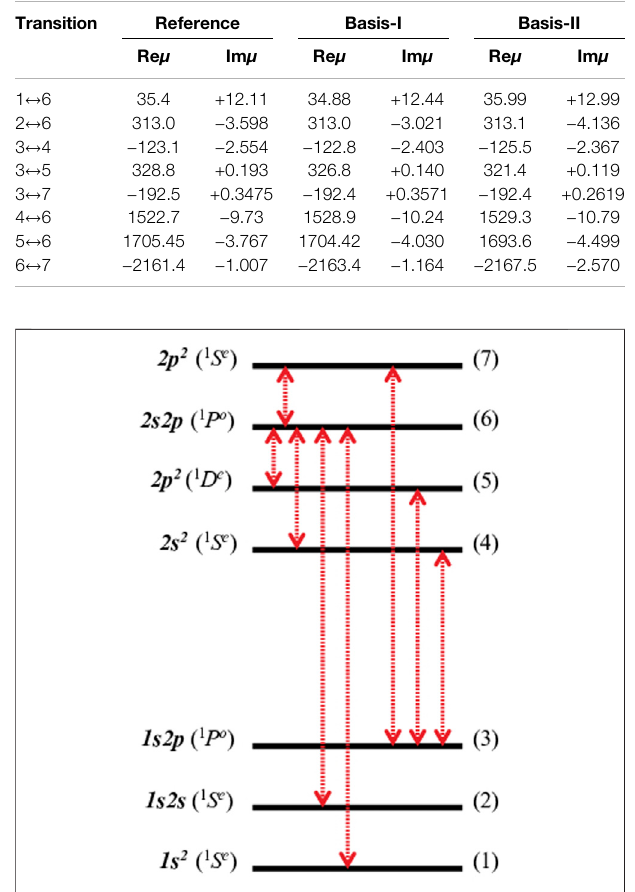
TABLE 2 | Complex transition dipoles of helium in milli-atomic units. The state labels in the fi rst column corresponds to the labels in Figure 6 . The reference values refer to a very accurate results obtained by complex scaling (CS) and full con fi guration interaction (FCI) with a very large (ExTG5G) basis set [36, 75]. The RVP transition dipoles are calculated using two type of truncated ExTG5G basis sets, where Basis-I is larger than Basis-II. Reprinted (adapted) with permission Ref. [74]. Copyright (2020) American Chemical Society.